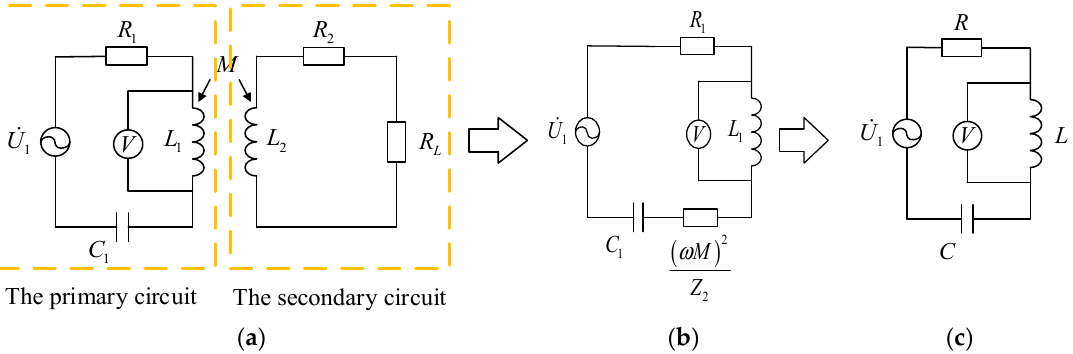
Figure 4. Equivalent conversion of the circuit of WPT. ( a ) The basic circuit of WPT, ( b ) The equivalent Circuit, ( c ) The simplified circuit.